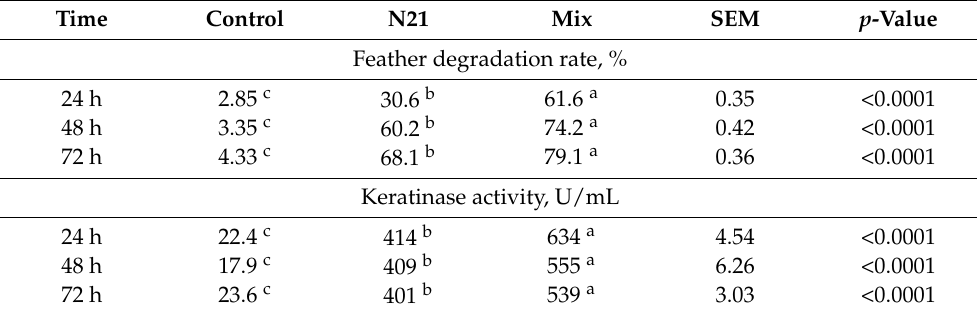
Table 2. The effect of liquid fermentation on feather degradation rate and keratinase activity.